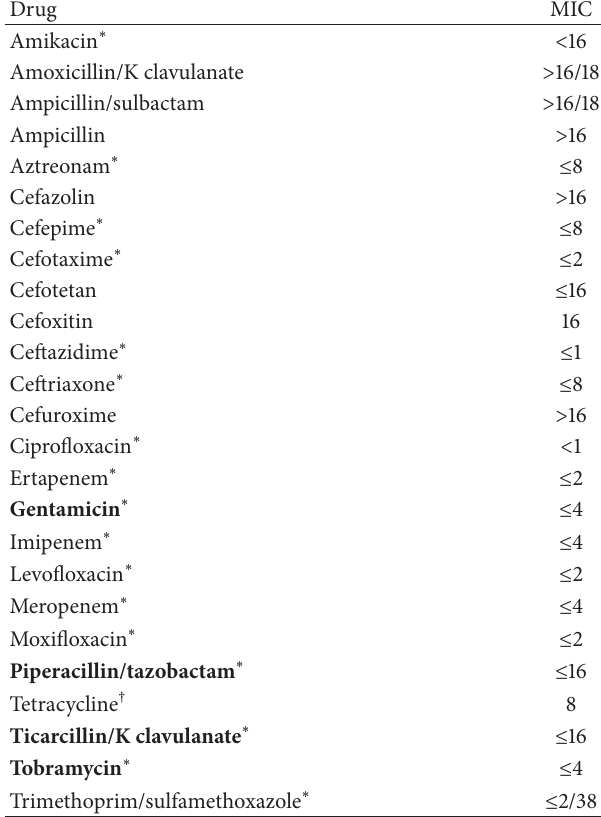
Table 2: Susceptibility results of our patient’s S. marcescens isolate to various antibacterial drugs. The bolded portions of the table indicate the drugs that were used in our patient’s treatment of S. marcescens . Gentamicin and tobramycin were only used in the cement spacer; vancomycin was not